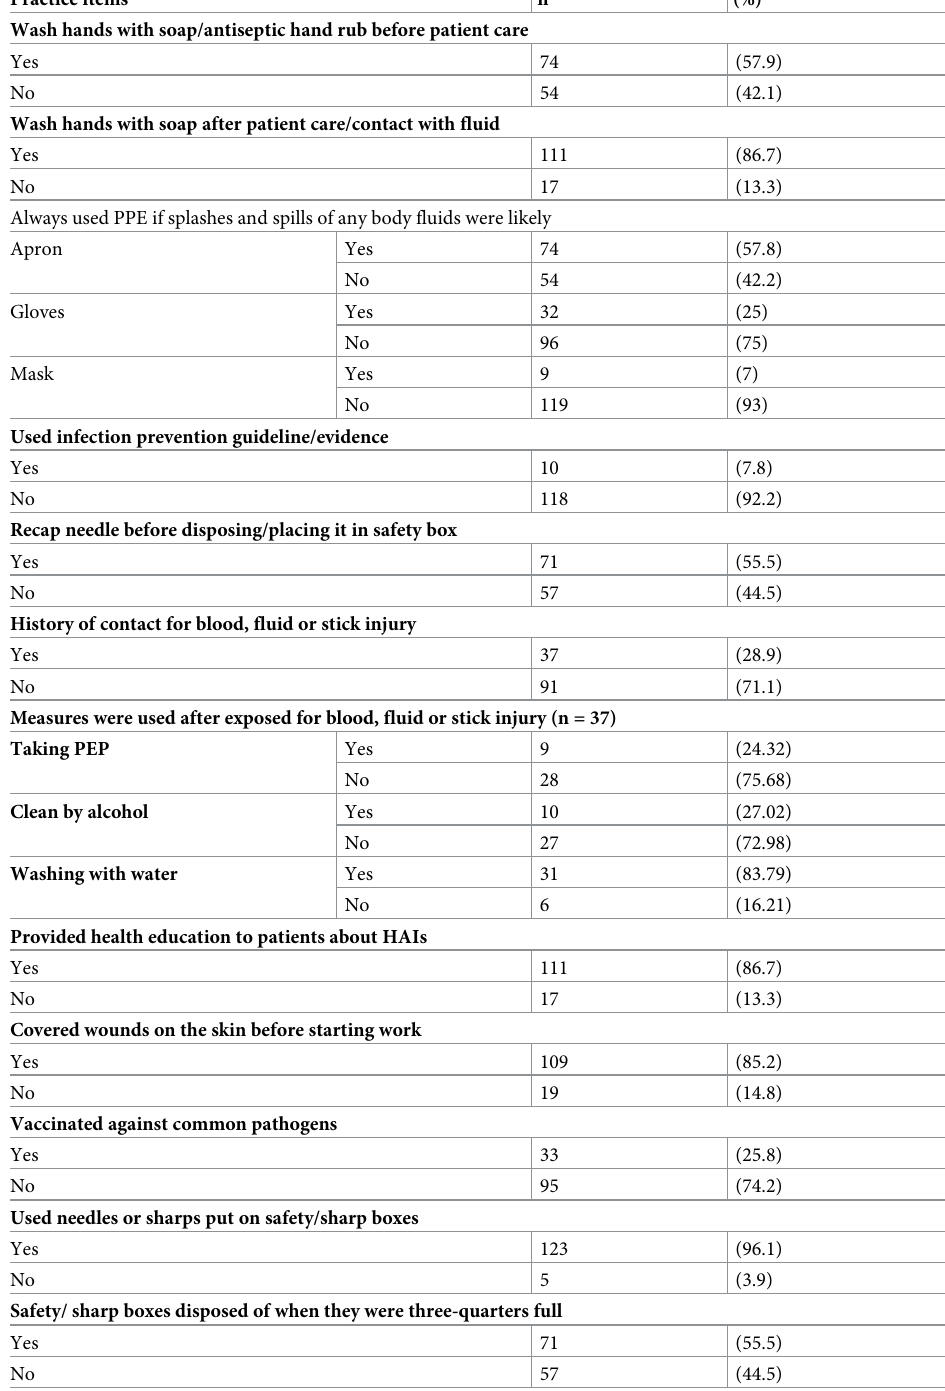
Table 3. Infection prevention practice of community healthcare